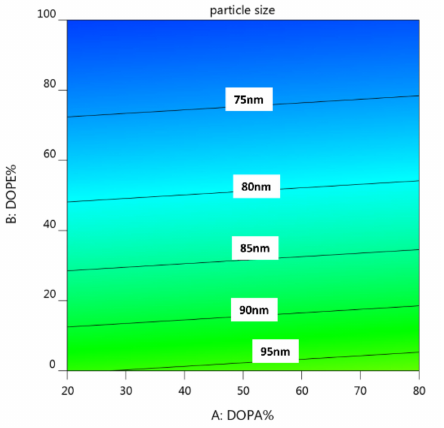
Figure 6. Contour plot for the interaction of lipid composition with particle size.